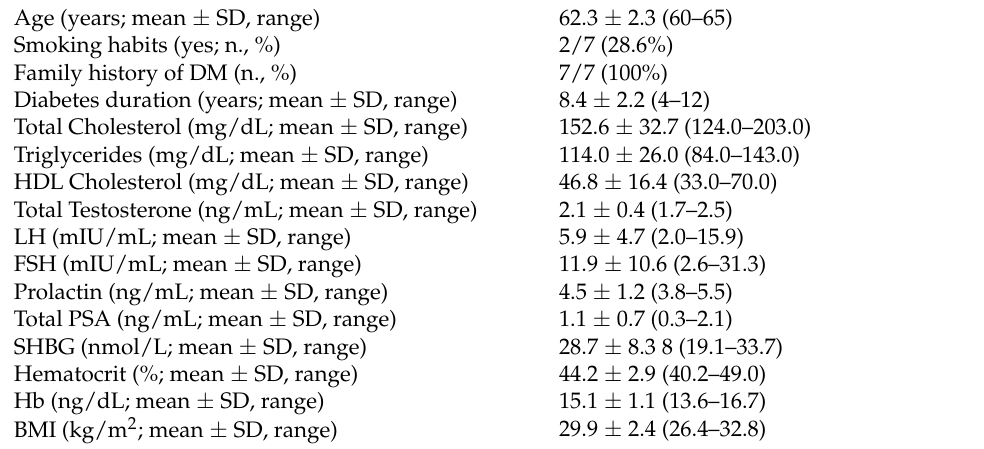
Table 1. Baseline characteristics of the population.